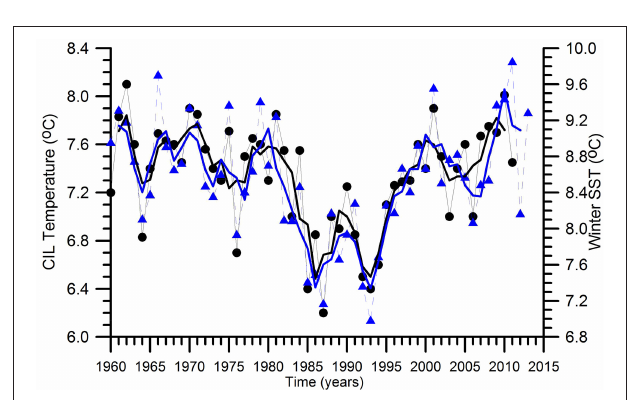
FIGURE 2 | Long term variations of the winter (December-March) mean sea surface temperature and the summer-autumn (May-November) mean Cold Intermediate Layer (CIL) temperature below the seasonal thermocline. The thin lines with symbols refer to the original data whereas the thick lines represent their smoothed variations by three point running